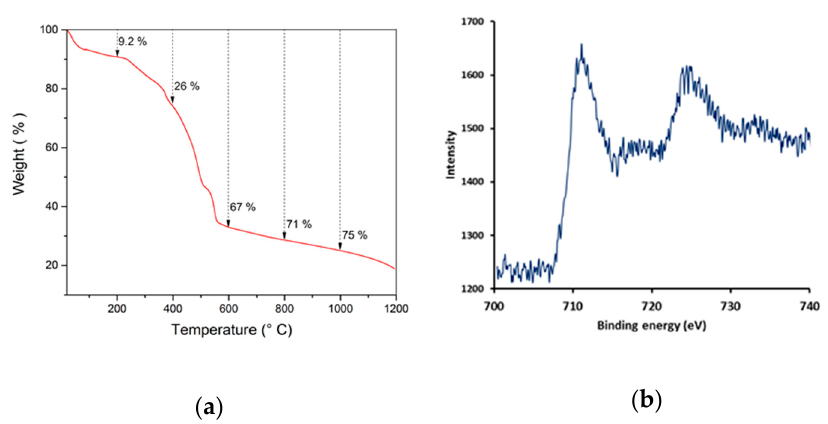
Figure 3. ( a ) TGA of MIL-53(Fe) powder under nitrogen with a heating rate of 5 ◦ C / min, ( b ) XPS Figure 3. (a) TGA of MIL-53(Fe) powder under nitrogen with a heating rate of 5 °C/min , (b) XPS Table 1. Effect of carbonization temperature and duration on the electro-Fenton performance of spectrum of pC@CF800 / 5h spectrum of pC@CF800/5h electrode. carbon felt electrodes modified with carbonized MIL-53(Fe).